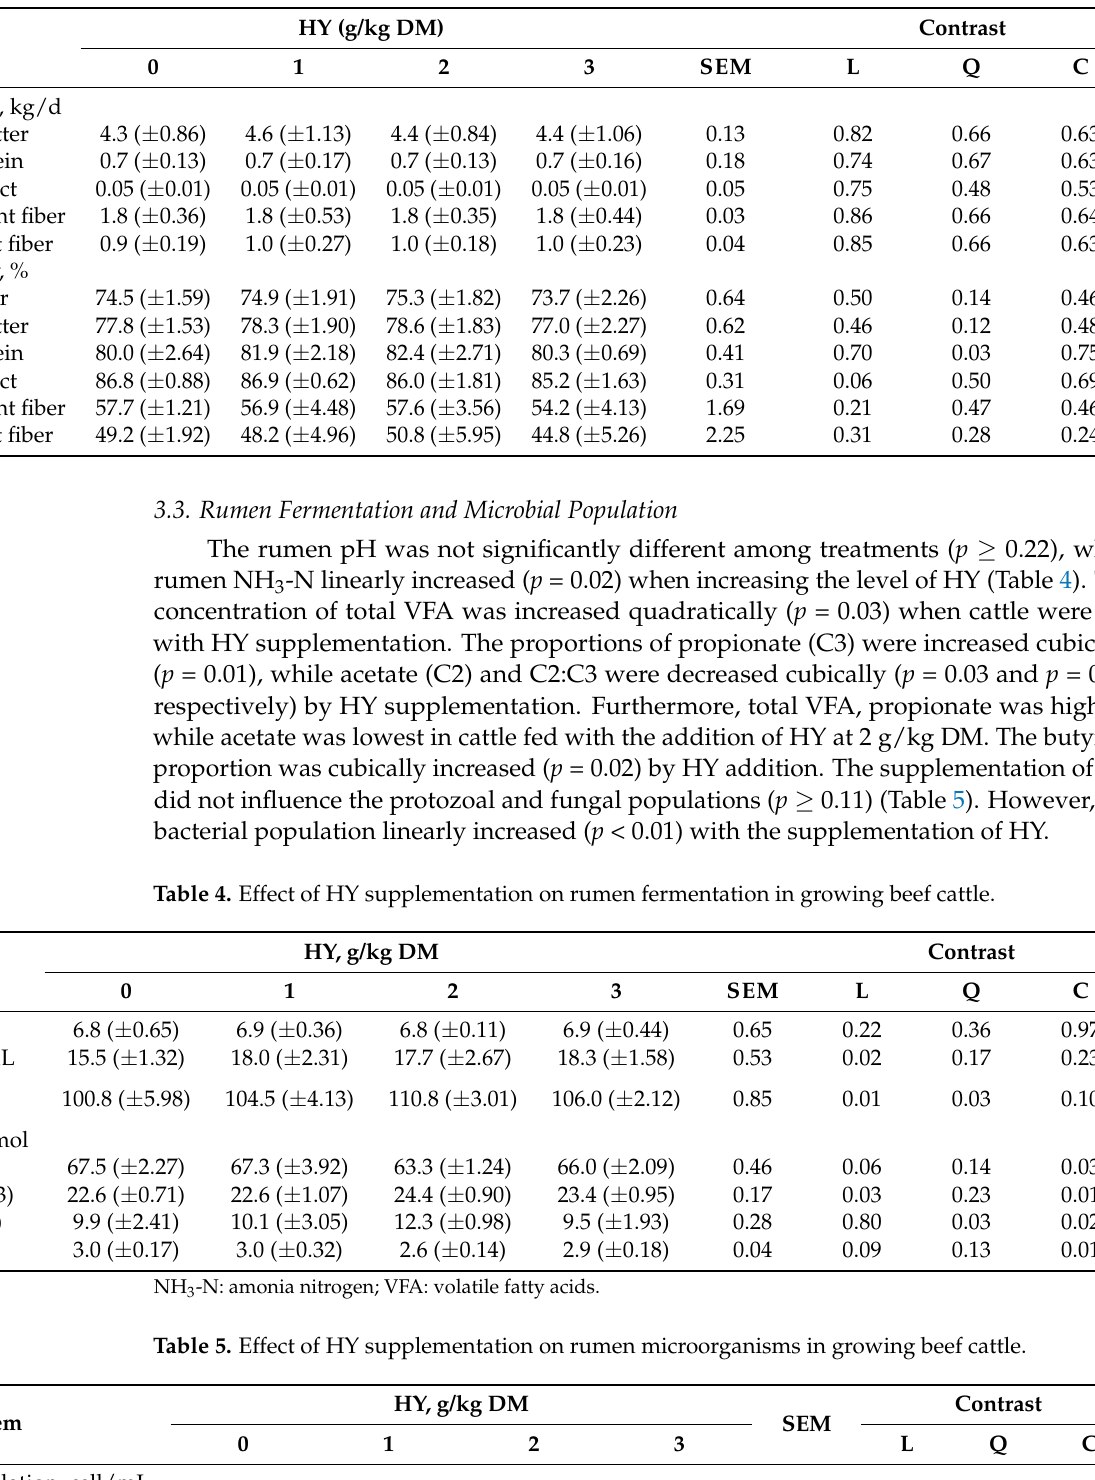
Table 3. Effect of HY supplementation on nutrient intake and digestibility in growing beef cattle.